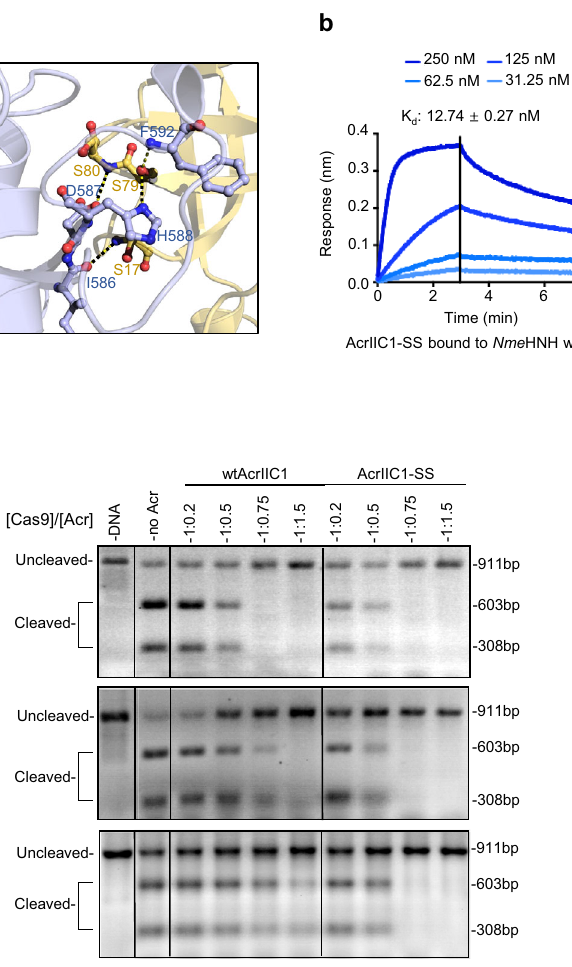
Fig.5|AcrIIC1-SSisarobust AcrIIC1variant.a Aclose-upviewoftheinterfaceof AcrIIC1-SS in complex with Nme HNH. The structural model was built using the SWISS-MODELwebsite(https://swissmodel.expasy.org)withPDBentry5VGBasthe template.AcrIIC1-SSiscoloredyellowand Nme HNHiscoloredpurple.Keyresidues involved in interfacial hydrogen bonds are drawn in sticks and labeled. b K d determined by BLI for AcrIIC1-SS bound to Nme HNH is 12.7nM with excess DTT in the reaction buffer. c Overlayof 1 H- 15 N HSQC spectraof AcrIIC1-SS(black), AcrIIC1- SStreatedwithexcessH 2 O 2 (blue),andAcrIIC1-SStreatedwithH 2 O 2 andmoreDTT in sequence (red) indicate the structure of AcrIIC1-SS is not affected by redox